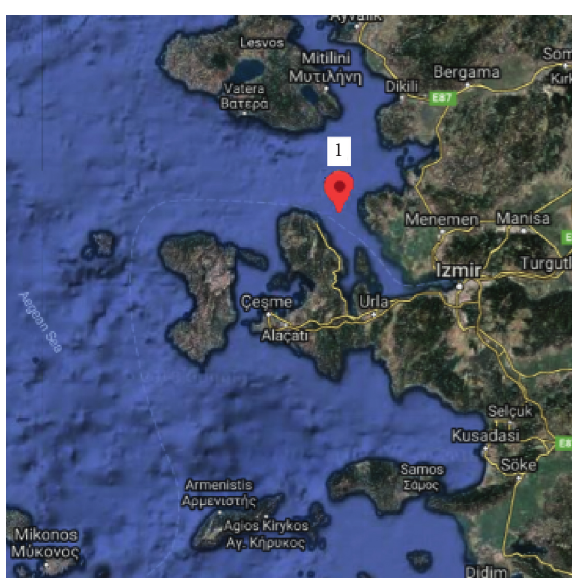
Figure 2: Sample collection from Aegean Sea, Izmir (38 ° 71 ′ N, 26 ° 61 ′ E).